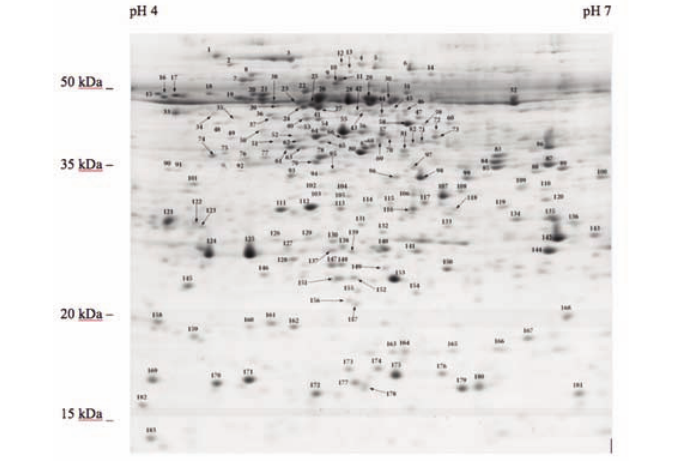
Figure 1. Representative SDS-PAGE gel of soybean lateral pulvinus, pH 4-7. The lateral and terminal pulvinus did not significantly differ from one another (data not